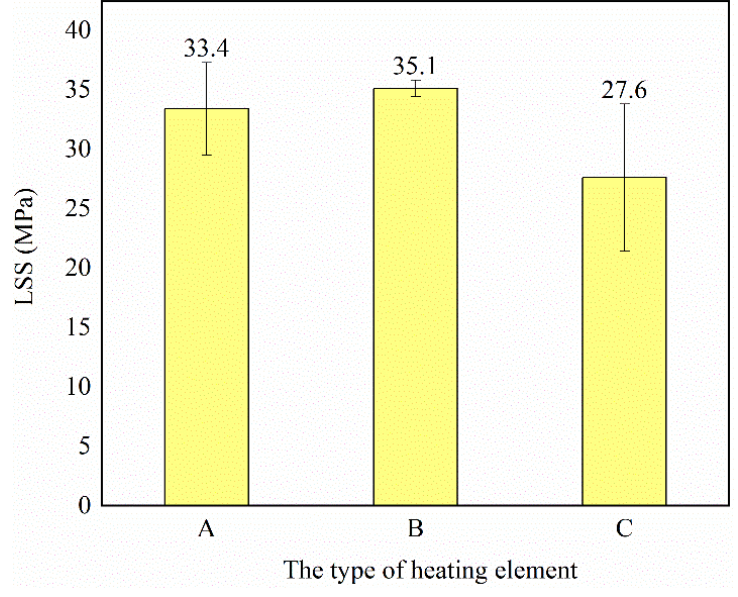
Figure 11. LSS of welded samples obtained with different types of heating elements listed in Table 5.